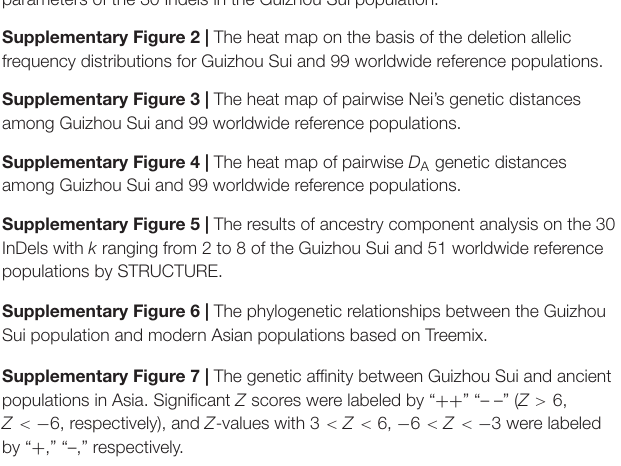
Supplementary Figure 1 | (A) Geographical distribution of Guizhou Sui in this study. (B) The linkage disequilibrium patterns among the 30 InDel loci of the